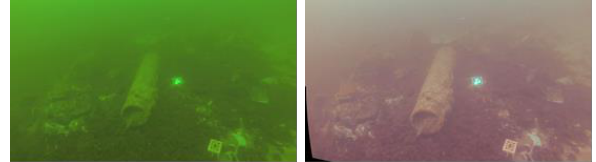
Figure 11. Original image (left) and refined image (right)